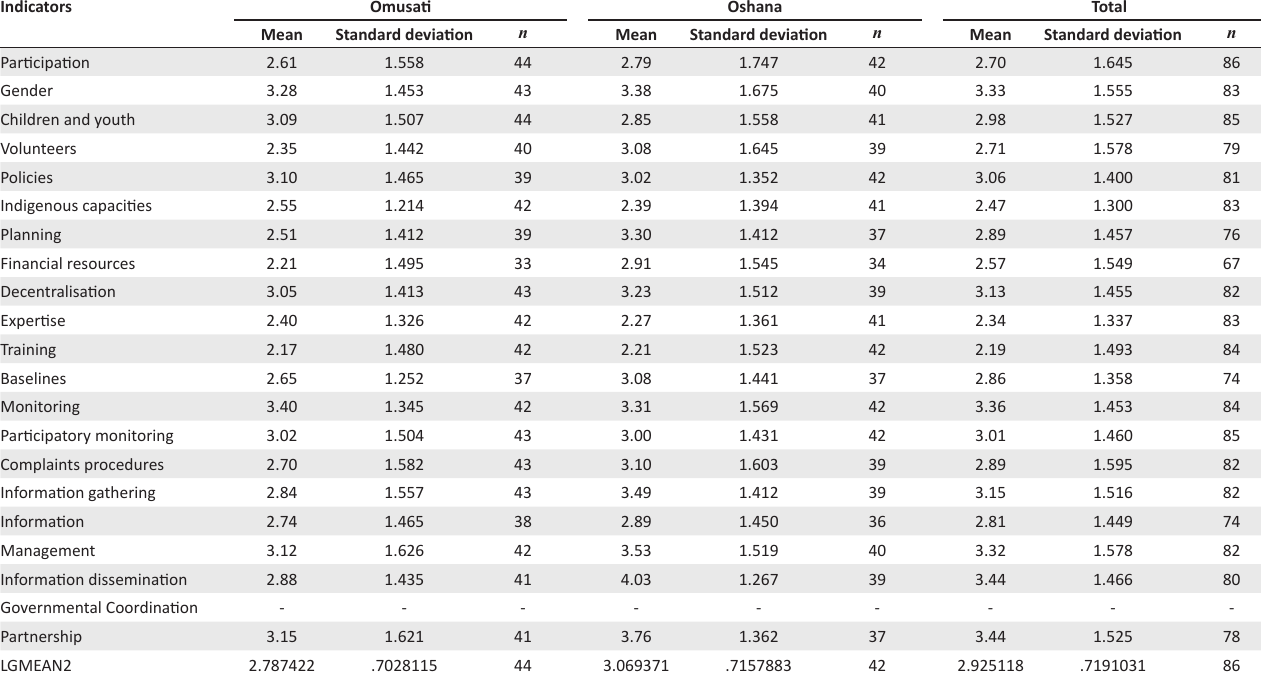
TABLE 16: Governance indicators region and mean scores.